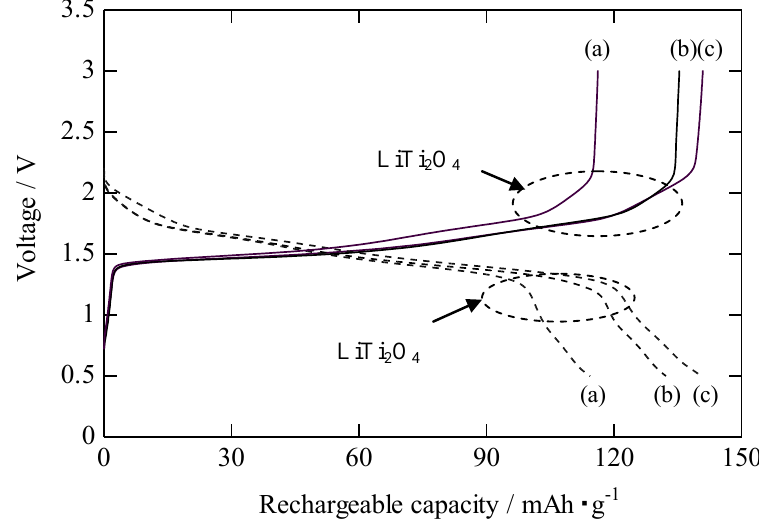
Figure 5. Rechargeable curves of RLTO anode material calcined at 1100  C under